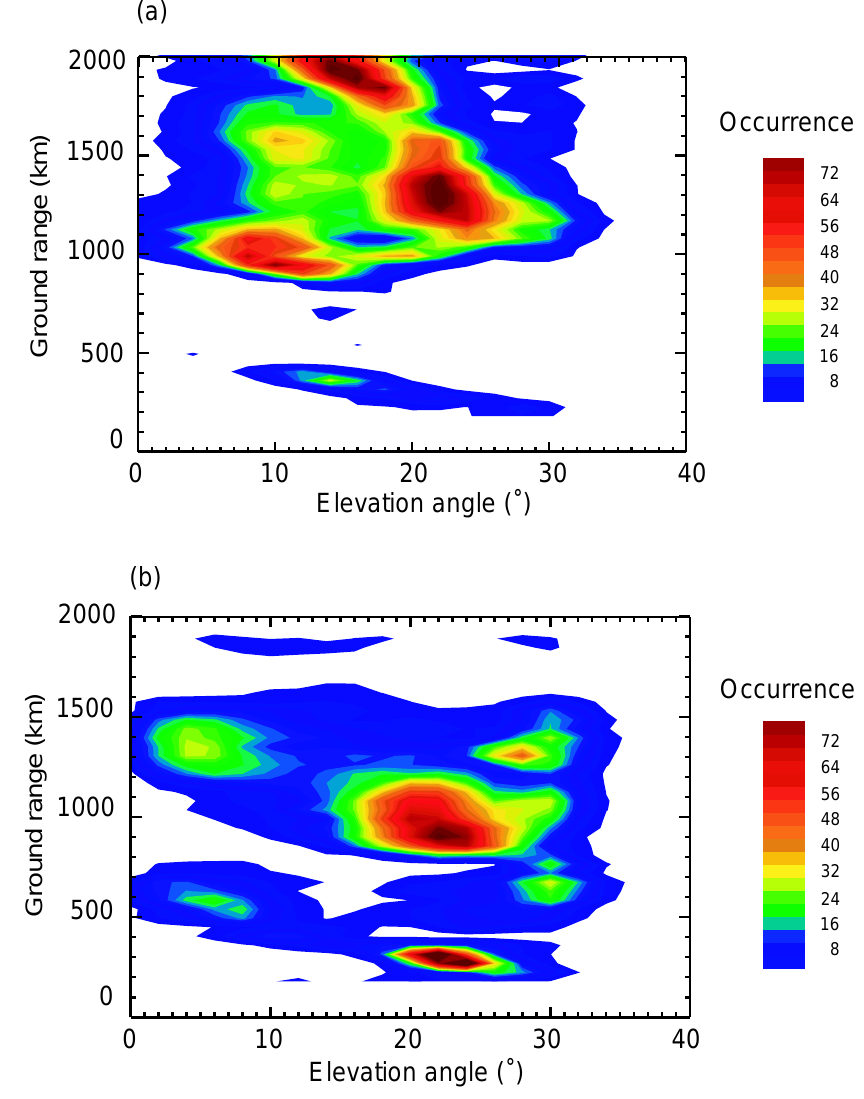
Fig. 9. The occurrence of measured Hankasalmi radar angle-of-arrival information as a function of ground range. Angle-of-arrival informa- tion from all beams of Hankasalmi are used. (a) The interval 22:20–22:50UT, before the substorm expansion phase onset (b) The interval 22:50–23:20UT, during the substorm expansion